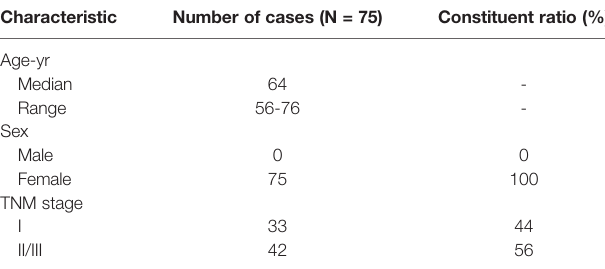
TABLE 1 | Baseline characteristics of patients (N = 75).